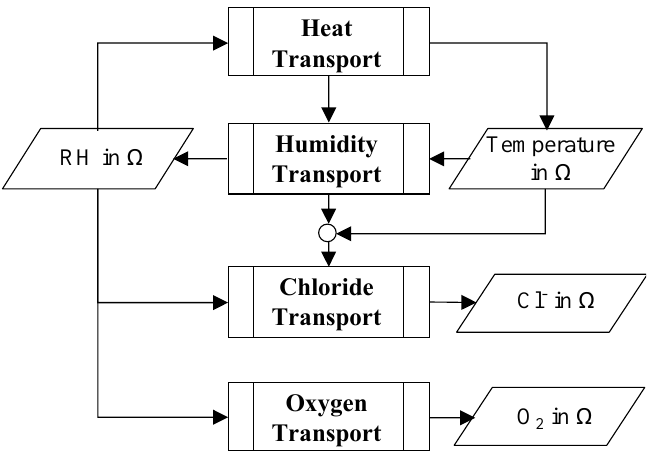
Figure 2. Coupling of heat, RH, Cl − , and O 2 transport in concrete (Ω represents the concrete domain).